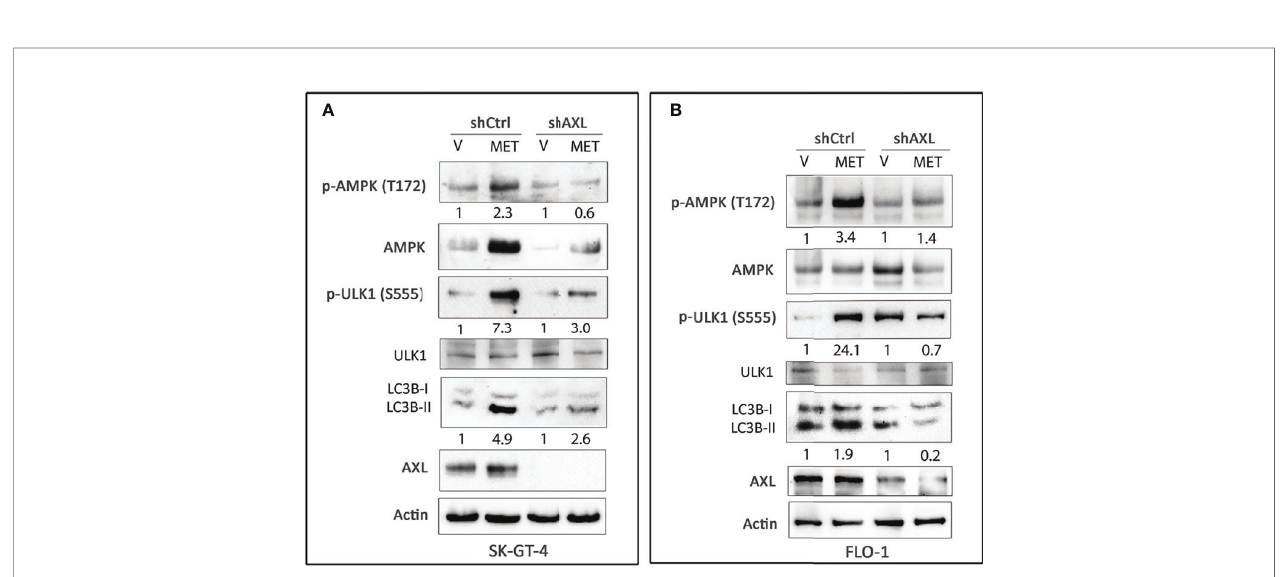
FIGURE 5 | Knockdown of AXL expression abrogates metformin-induced autophagy in EAC cells. Western blot analysis of p-AMPK (T172), AMPK, p-ULK1 (S555), ULK1, LC3B, and AXL proteins in whole cell lysates from SK-GT-4-shCtrl and SK-GT-4-shAXL cells (A) and FLO-1-shCtrl and FLO-1-shAXL cells (B) following treatment with vehicle or metformin (15 mM or 10 mM) for 2 h. Gel loading was normalized for equal b -actin. Data are representative of three independent